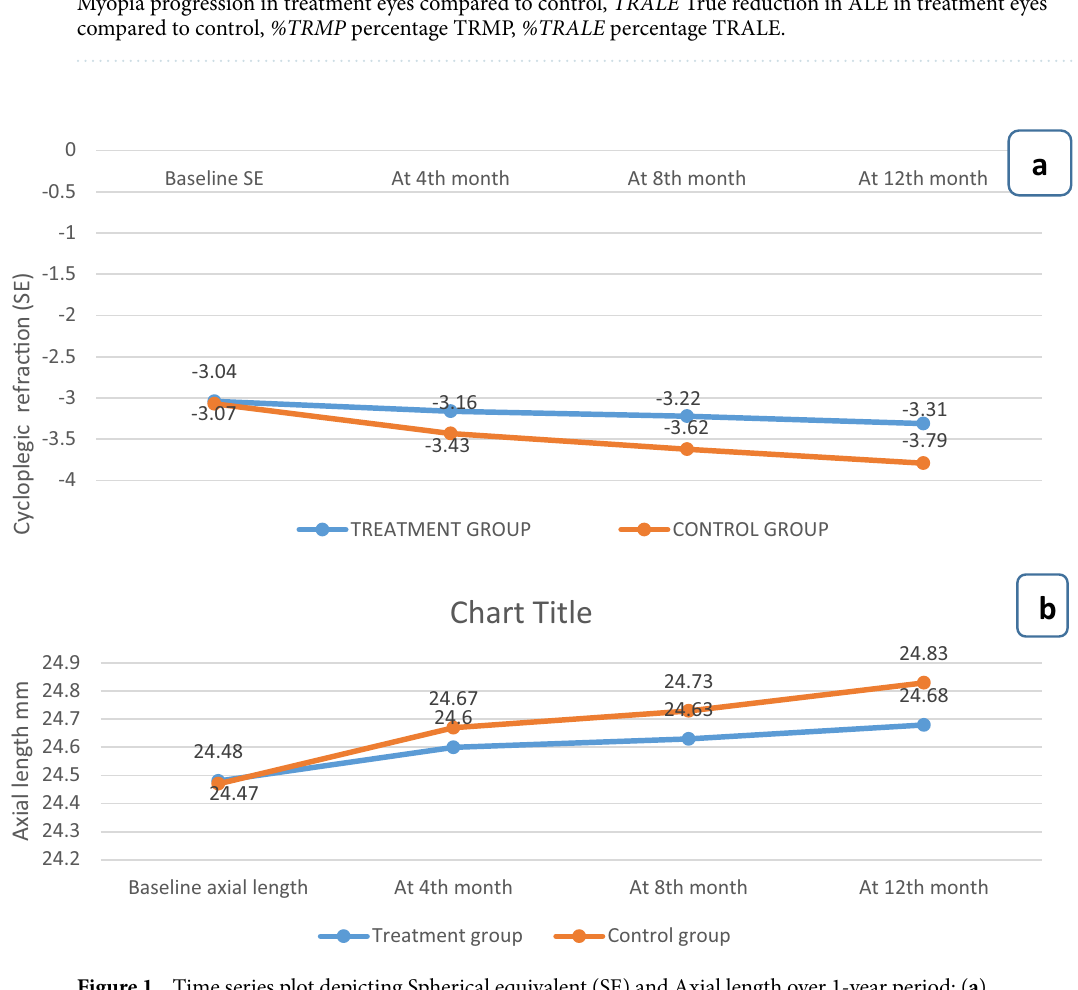
Figure 1. Time series plot depicting Spherical equivalent (SE) and Axial length over 1-year period: ( a ) Comparison of change in cycloplegic refraction (in terms of SE) in treatment group and control group during study period. ( b ) Comparison of axial length in treatment group and control group during study